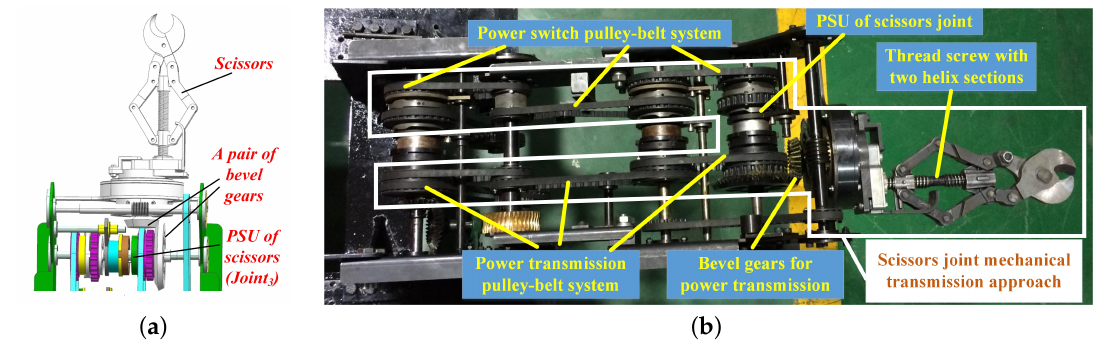
Figure 21. Illustration of the scissor joint. ( a ) The 3D model of scissors joint. ( b ) The prototype of scissors